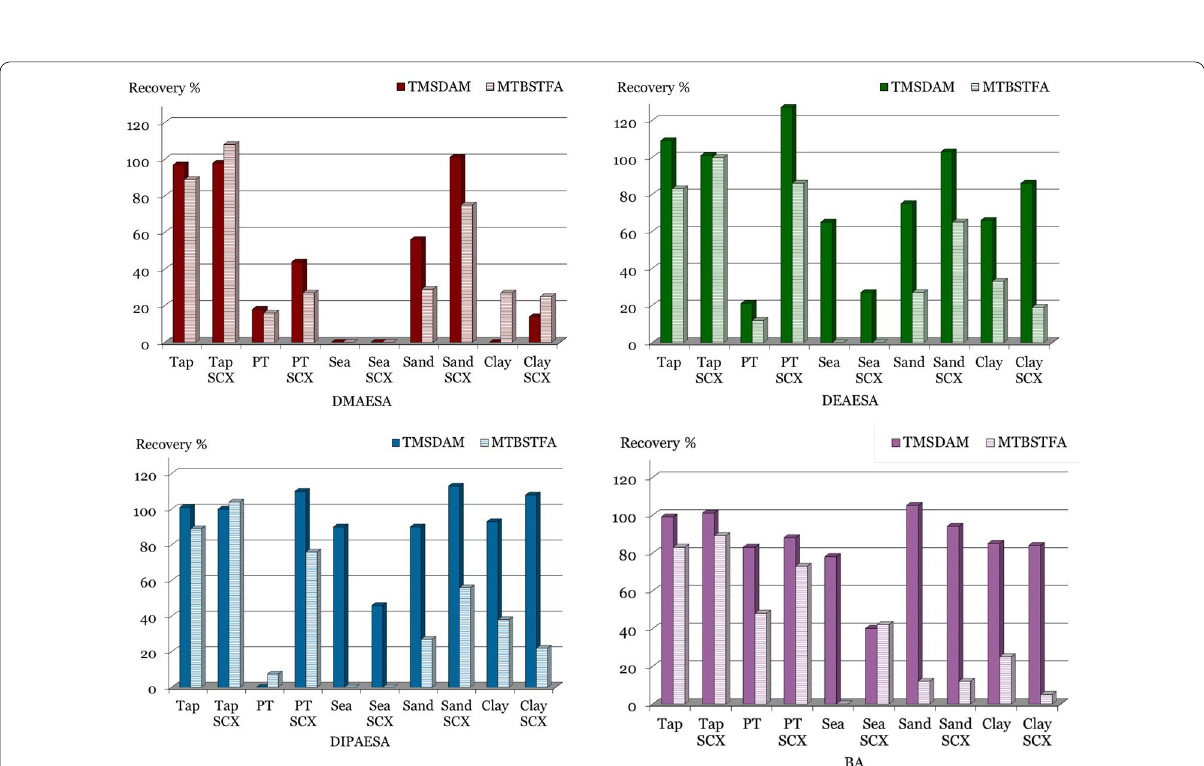
Fig. 7 Recovery (%) of SAs and BA (20 μg/ml) in different water samples and soil extracts without and with cation exchange. The samples were silylated with MTBSTFA or methylated with